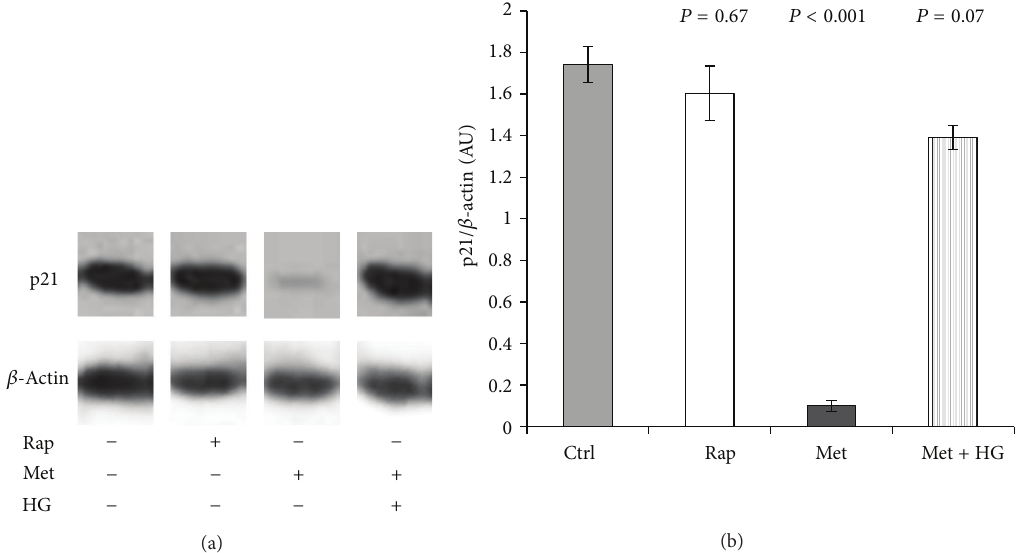
Figure 9: Metformin inhibits p21 expression in podocytes. The cells were treated with 5.5 mM or 25 mM D-glucose for three days. For the last 24h, 8 mM metformin or 100nM rapamycin were added. (a) Western blotting was performed for p21 and 𝛽 -actin. (b) Band intensity was quantified by densitometry. Data are arbitrary units (AU) expressed as mean ± SEM ( 𝑛 = 3